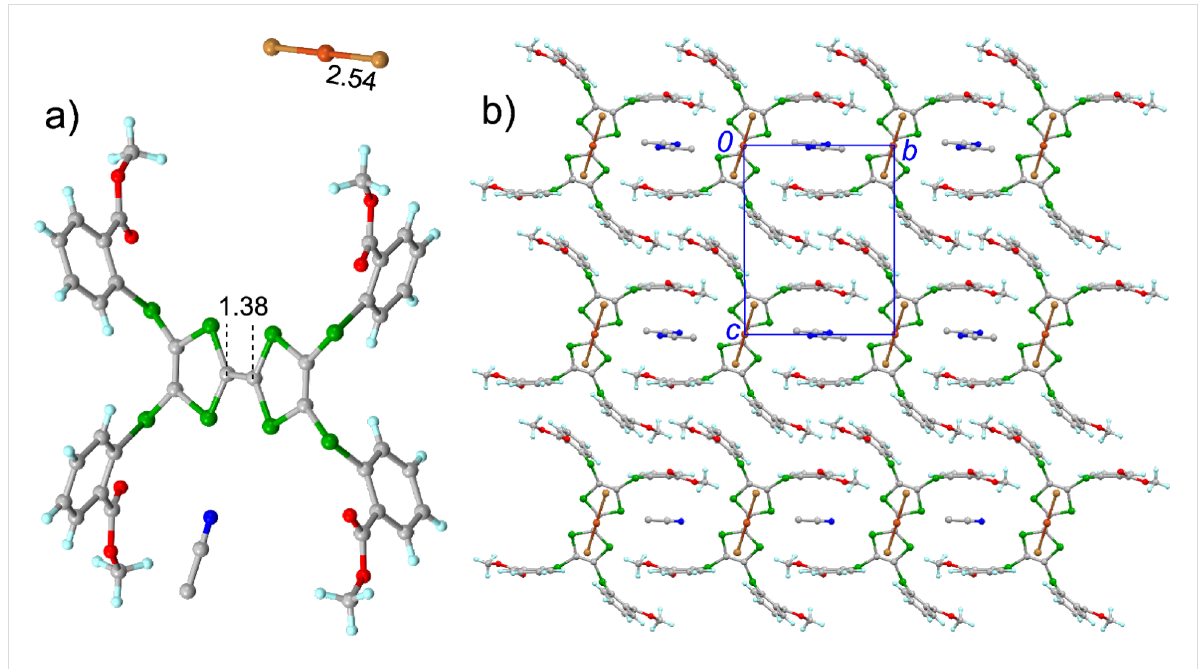
Figure 5: Crystal structure of 6 ·CuBr 2 ·CH 3 CN: a) unit cell contents with the typical bond lengths shown (Å); b) packing structure viewed along the crystallographic a -axis.